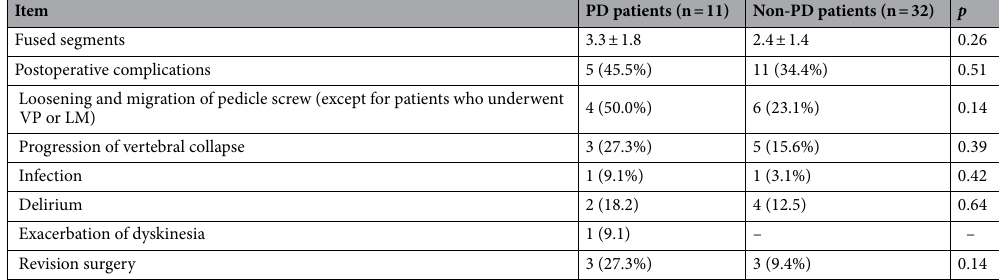
Table 4. Postoperative complications in patients with and without Parkinson’s disease. PD Parkinson disease, VP Vertebroplasty, LM Laminotomy.